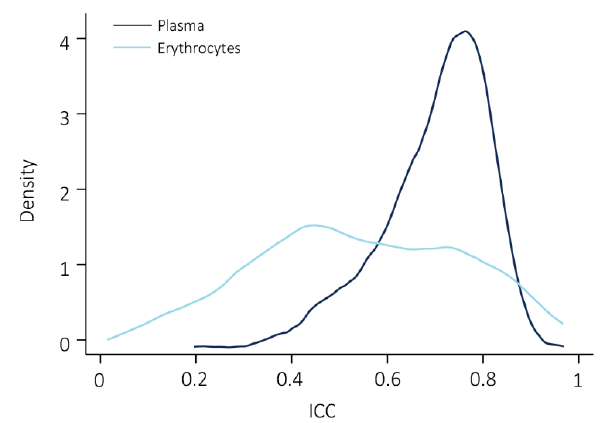
Figure 4. Density plot of the ICC score distribution of lipids measured in plasma and erythrocytes, with a p ‐ value < 0.001.